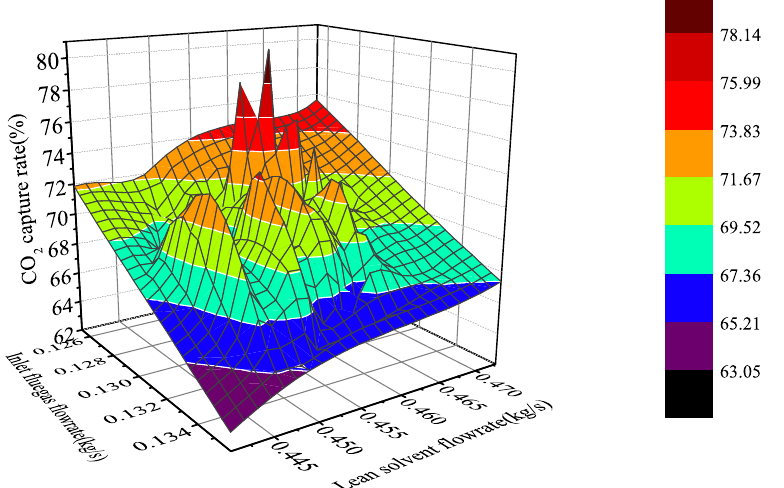
Figure 4. Non-linear distribution of CO 2 capture system under different working conditions.